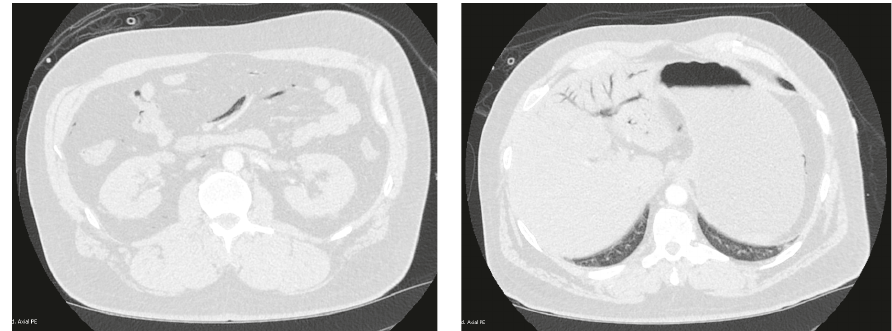
Figure 2: Mesenteric venous gas and pneumobilia.